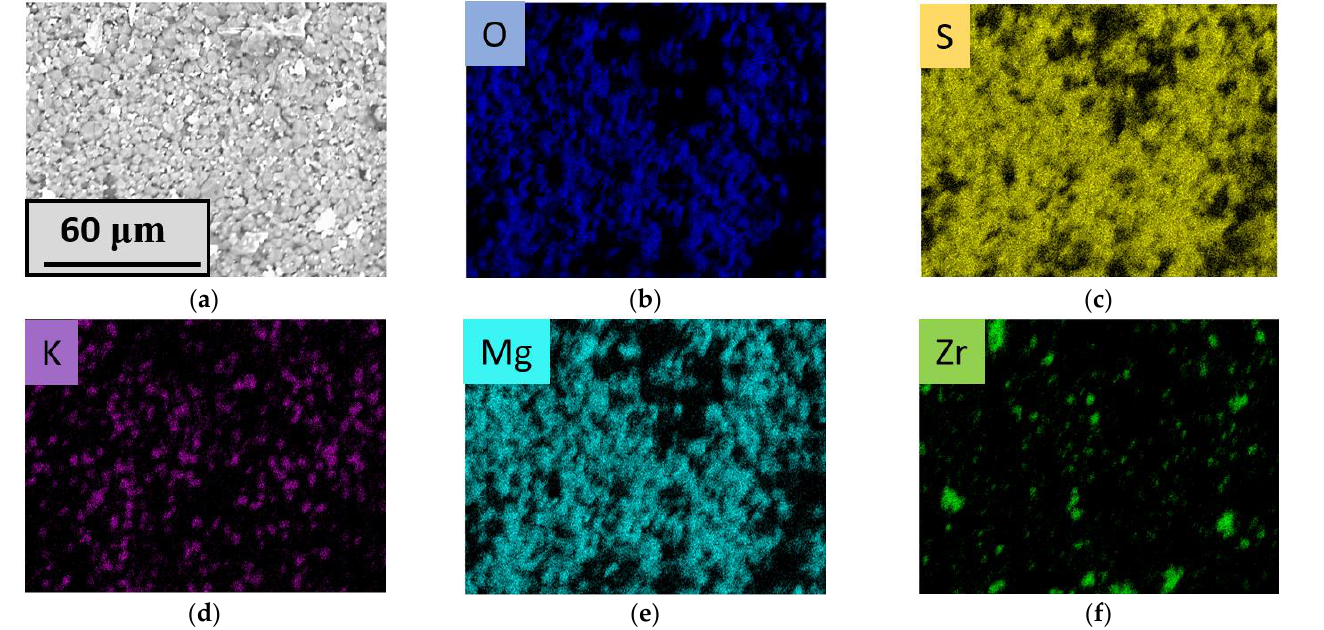
Figure 4. ( a ) SEM image of Mg10KY-TZP; ( b – f ) corresponding elemental